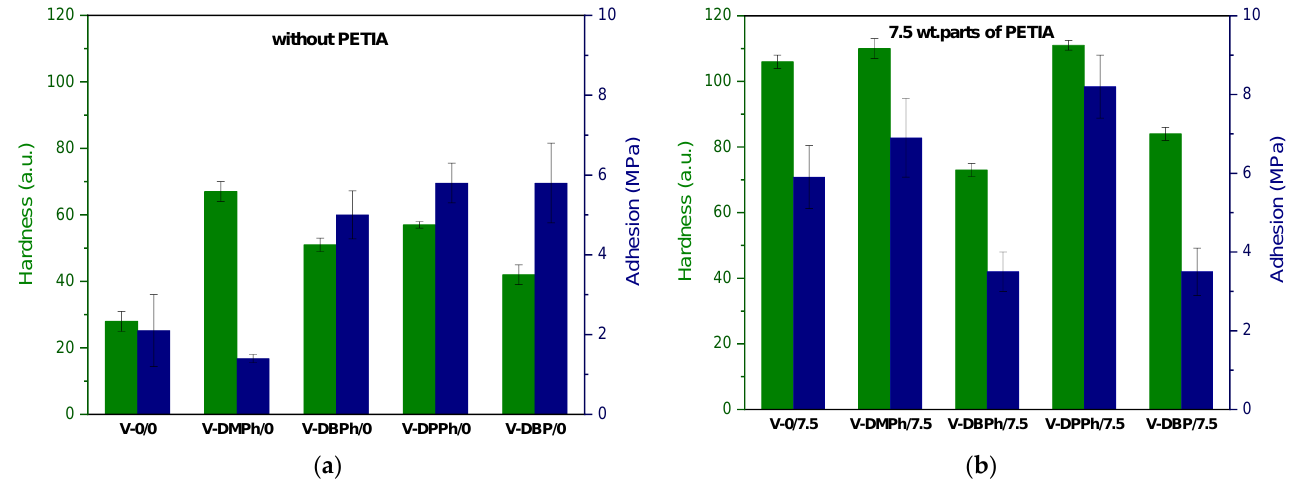
Figure 5. The values of hardness and adhesion of UV-cured varnish coatings: without crosslinking monomer PETIA ( a ), with 7.5 wt. parts of crosslinking monomer PETIA ( b ).